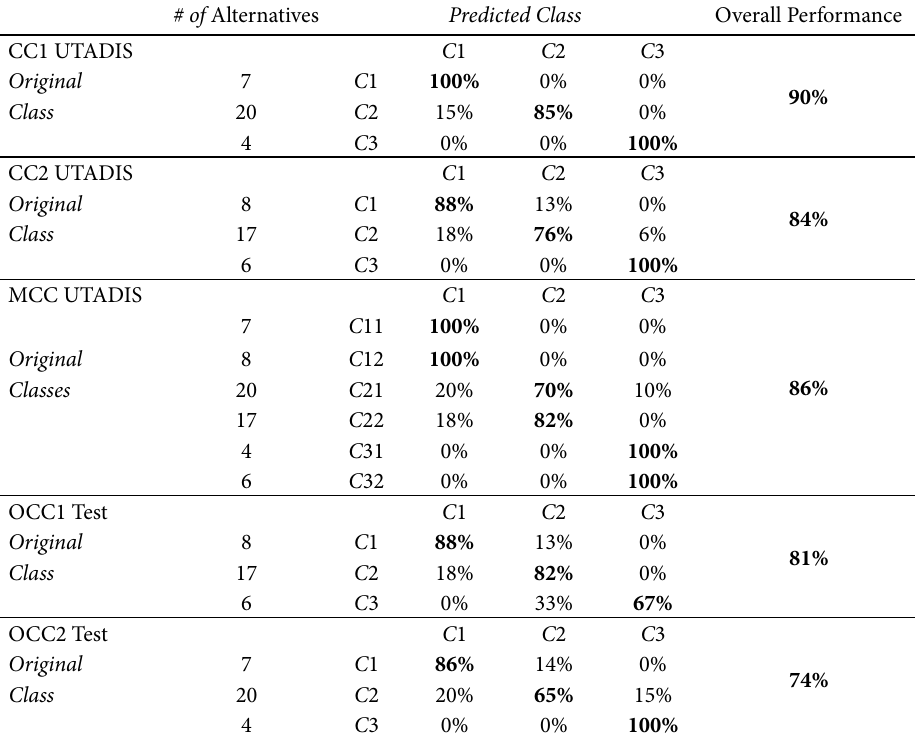
table 4. Prediction and explanation ability of the models # of Alternatives Predicted Class Overall